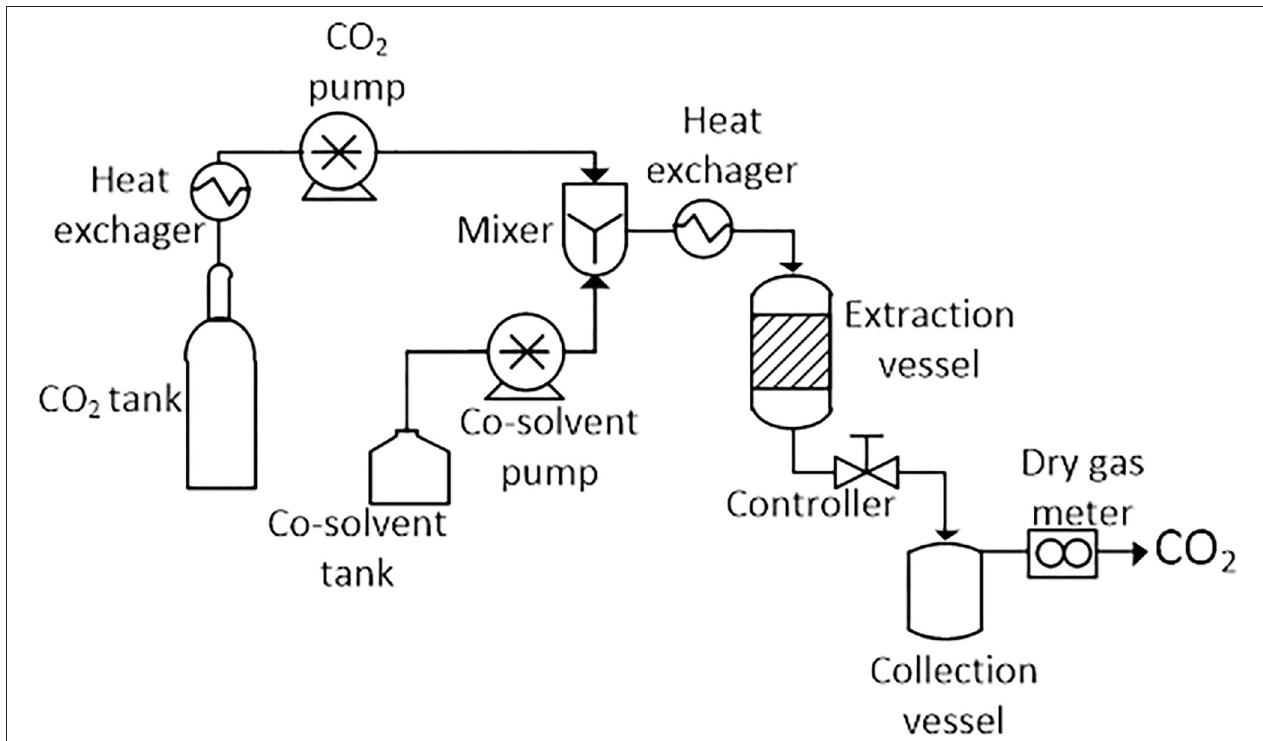
FIGURE 4 | Schematic diagram of a typical supercritical fluid extractor. Adapted of Azmir et al. (2013) and Yahya et al. (2018).